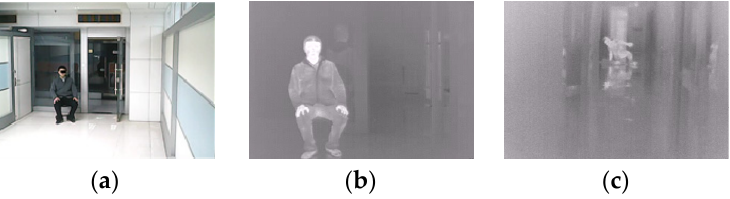
Figure 1. Examples of imaging effects. ( a ) Visible light image. ( b ) Thermal imaging image taken in the same scene as ( a ). ( c ) Image of a person suddenly falling down.